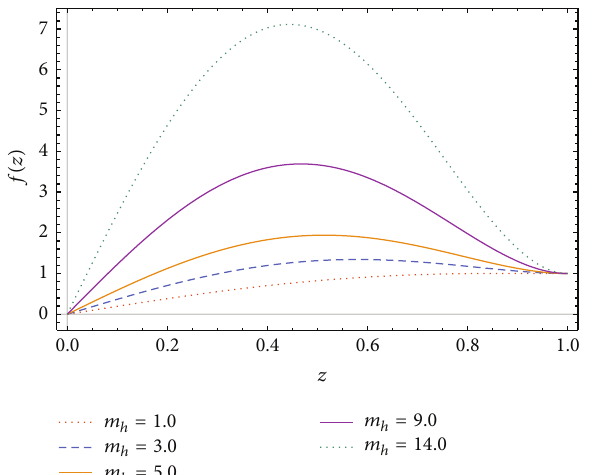
Figure7: Velocity profilefordifferent values of 𝑚 ℎ with 𝑚 𝑝 = 𝑅 𝑚𝑝 = 1 .